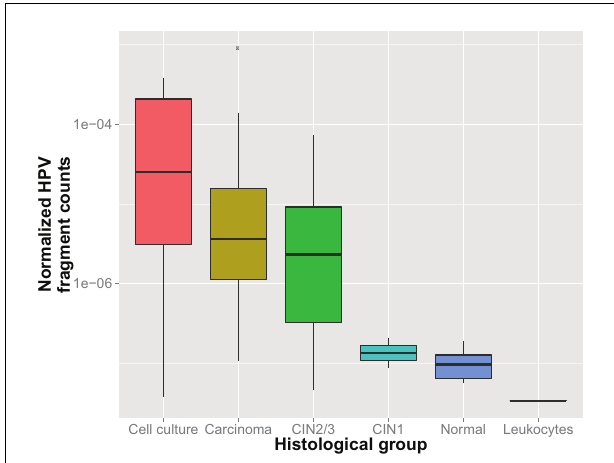
FIGURE 2 | Normalized HPV fragment counts ( R vs ) within each sample for which HPV was found, per histological group.